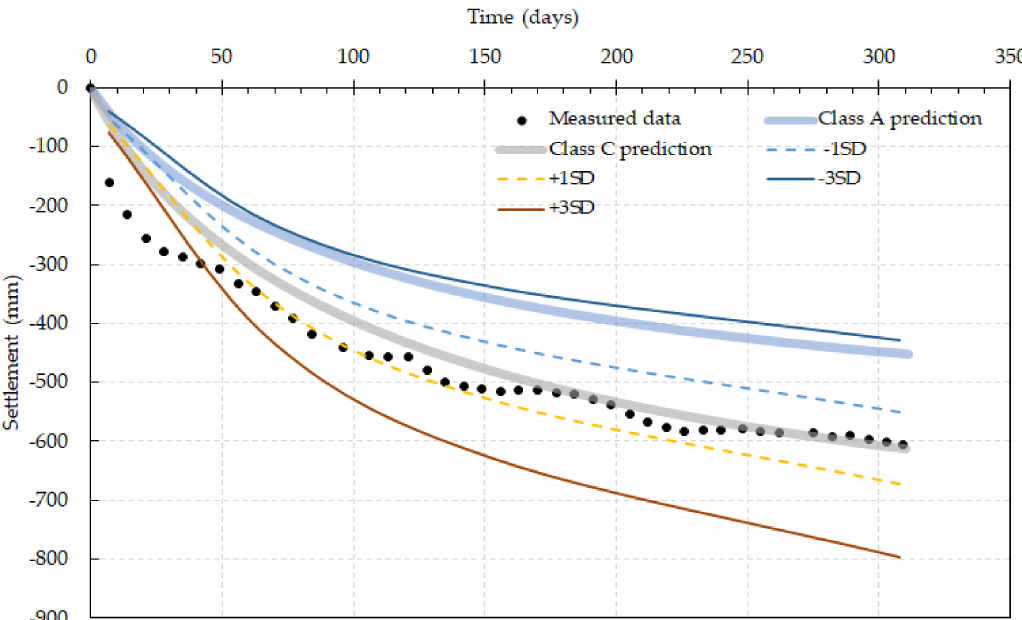
Figure 10. Measured and Predicted settlement for mean values ± 1SD and ± 3SD for Karakore clay.